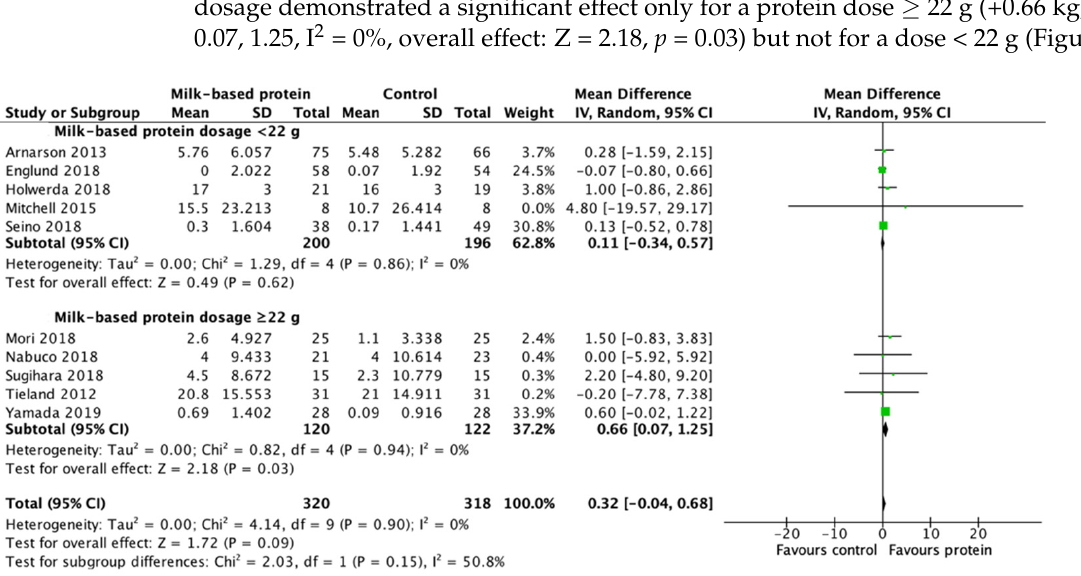
Figure 8. Forest plot for the differences in RT-induced increases in 1RM knee extension between consuming milk-based protein supplements and control supplements considering the subgroup analysis of protein dosage.